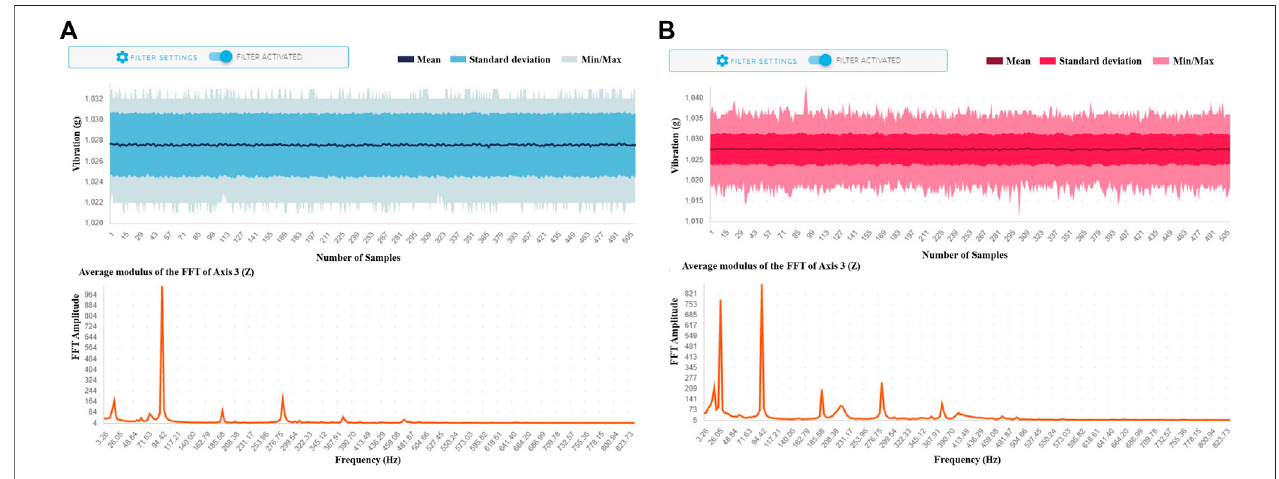
FIGURE 10 | Visualization of normal (A) and abnormal (B) signals.